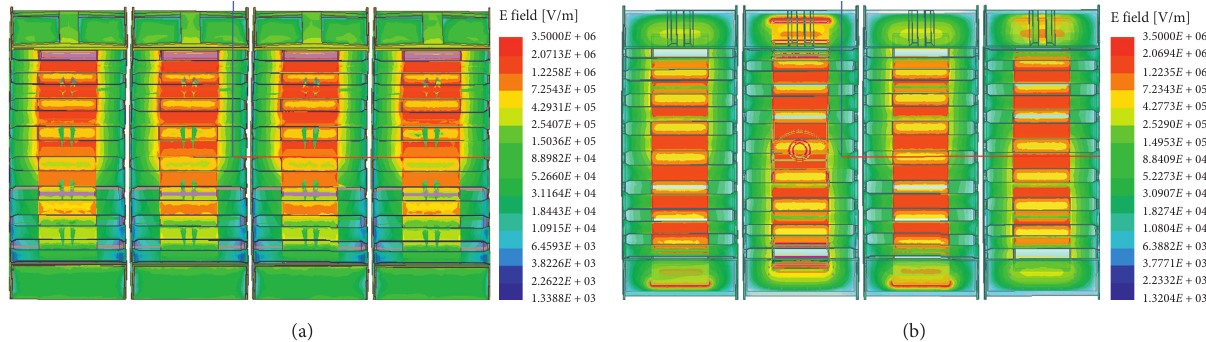
Figure 7: Normalized E field distribution of the two versions of the antenna at (0, 0, 0, 0) and 30MHz before optimization (a) and after optimization (b).